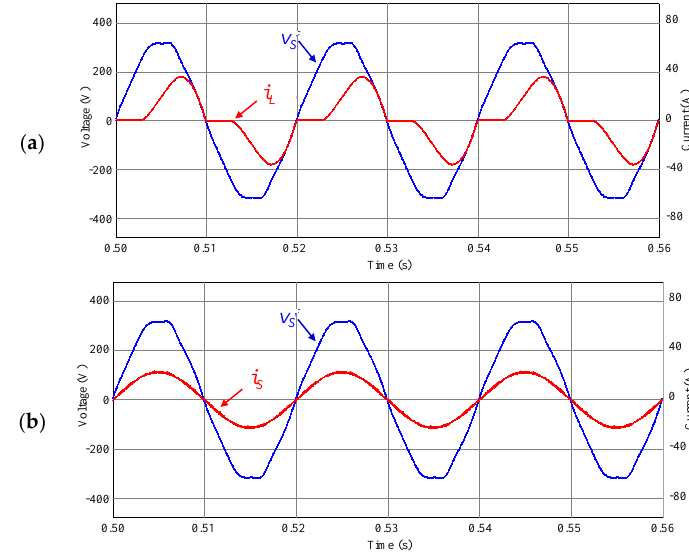
Figure 12. Steady-state analysis of the SAPF operation with non-linear load: ( a ) Source voltage ( v S ) and load current ( i L ); ( b ) Source voltage ( v S ) and source current ( i S ).